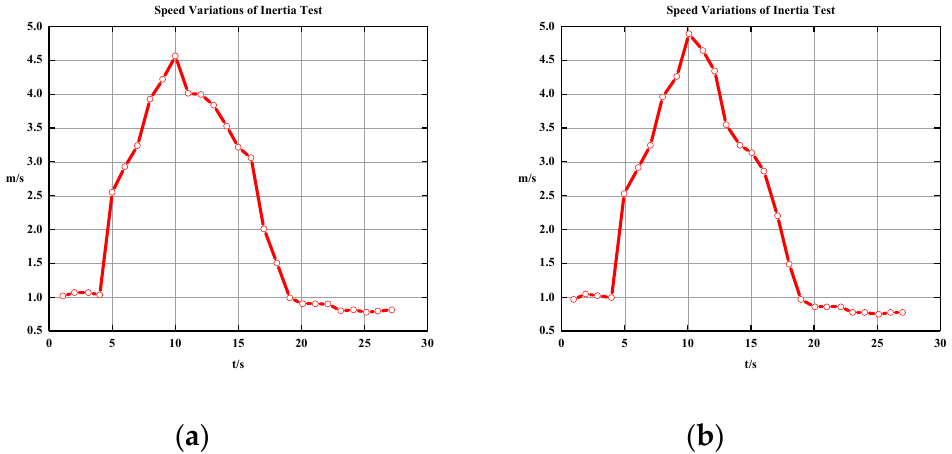
Figure 5. Velocity curve of inertia test at ±10° course angle ( a : − 10° course angle; b : 10° course angle).